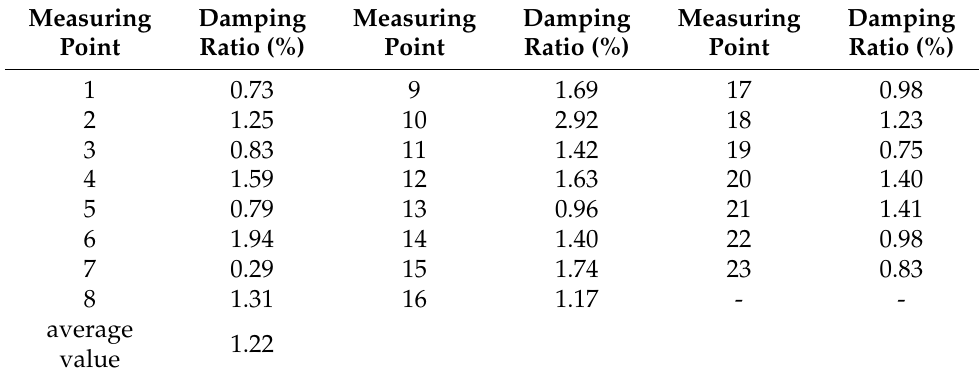
Table 2. Damping test results.